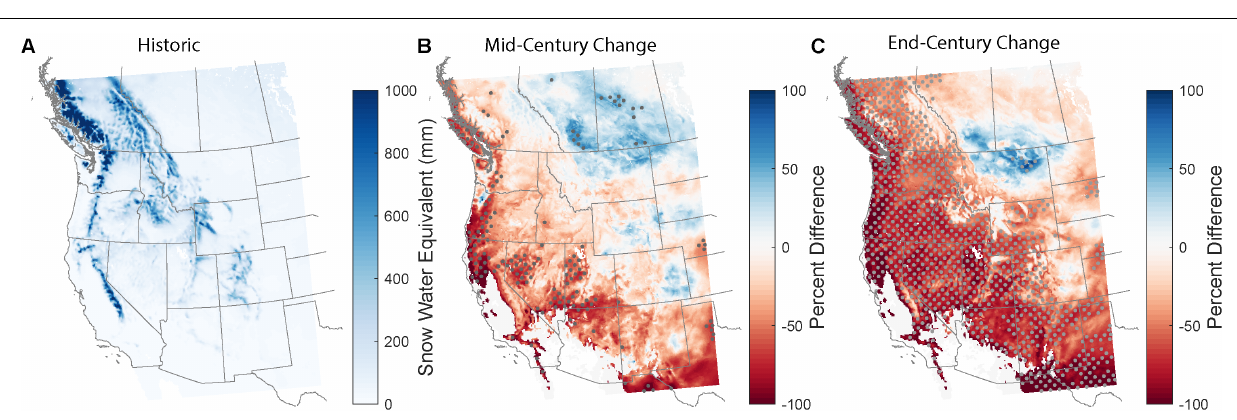
FIGURE 9 | (A) Average annual maximum snow water equivalent (SWE) from WRF/CCSM for the historical decade. (B,C) Percent difference in peak SWE when comparing the mid-century (B) and end-century (C) decades to the historic. Stippling indicates regions with a statistically significant change by mid- or end-century at the 95% confidence